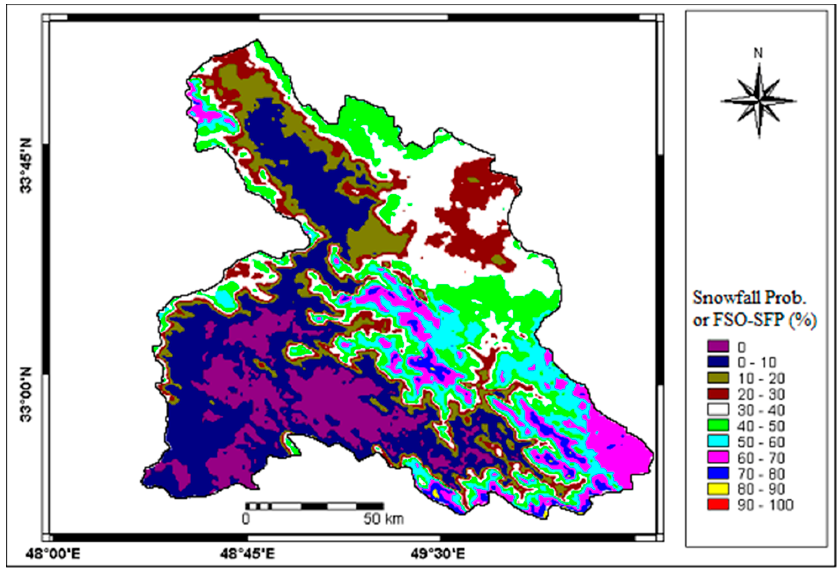
Figure 6. FSO ‐ SFP Map in Dez Basin (for the period of 1984–2003).